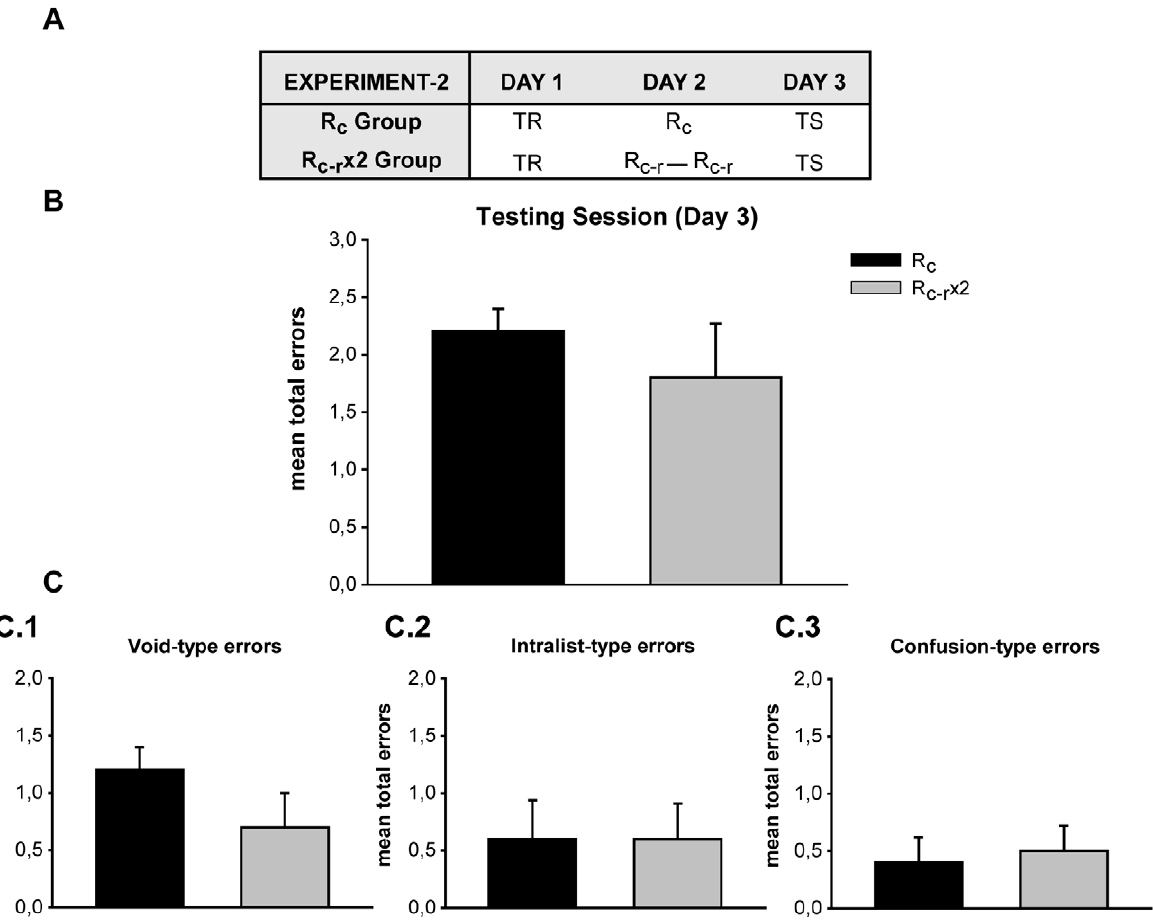
Figure 2. Experiment 2 (n=10). Successive retrievals do not strengthen the declarative memory. A ) Experimental protocol. A three-day experiment. Symbols as in experiment 1, R c-r stands for the cue-response reminder. Group R c received a cue reminder, Group R c-r x2 received the cue- response reminder twice. B ) Testing session. Mean number of total errors + / 2 SEM on Day 3. Black bar stands for Group R c , grey bar for Group R c-r x2. C ) Error Type. C.1) Mean number of Void-type errors + / 2 SEM on Day 3. C.2) Intralist-type errors C.3) Confusion-type errors. Symbols as above.